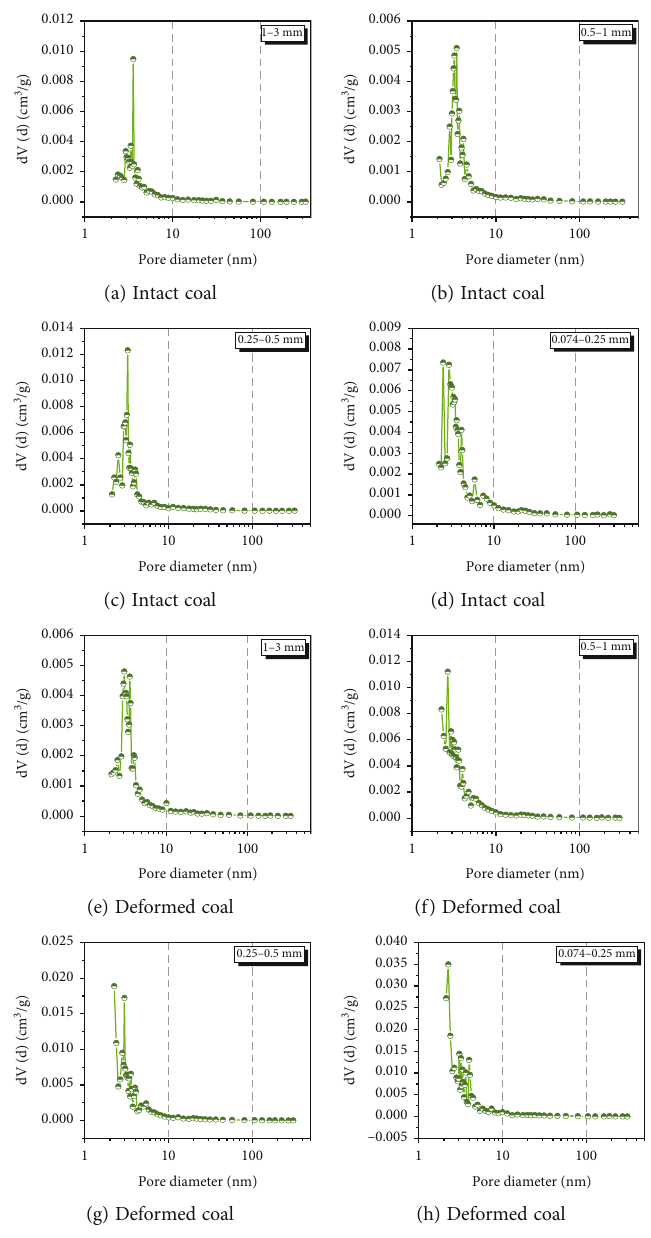
Figure 7: PSDs of minipores and